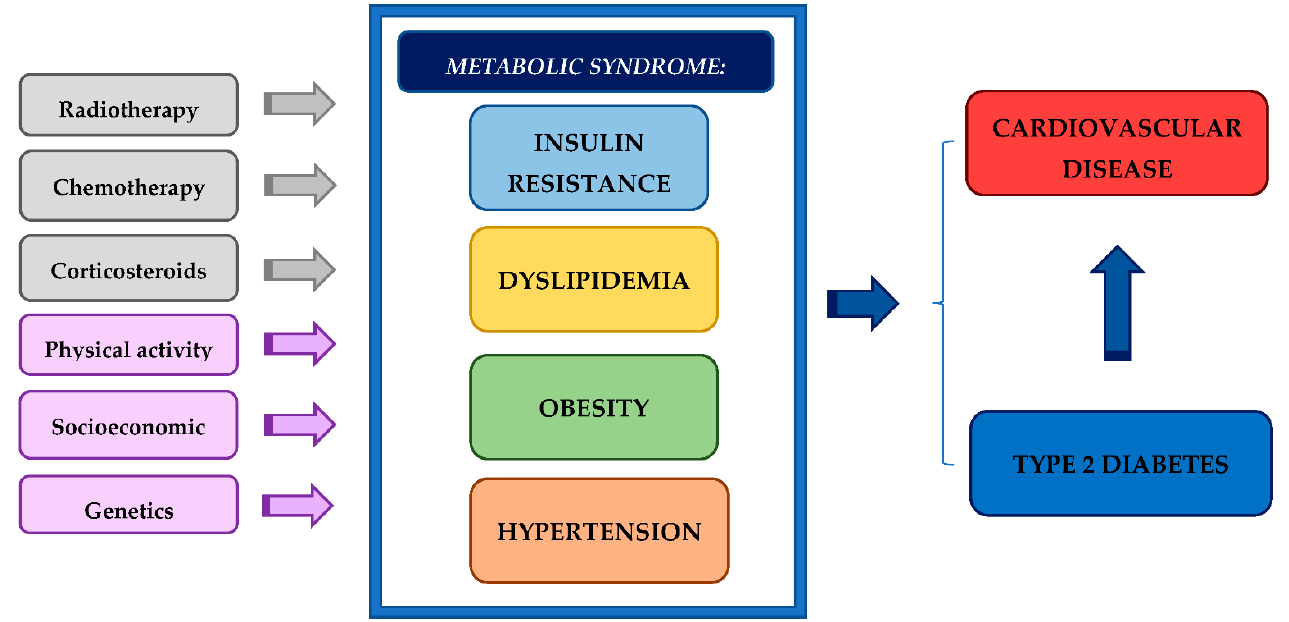
Figure 1. Treatment and environmental factors of the component of metabolic syndrome in childhood cancer survivors and the resulting risk of developing cardiovascular disease and type 2 diabetes.